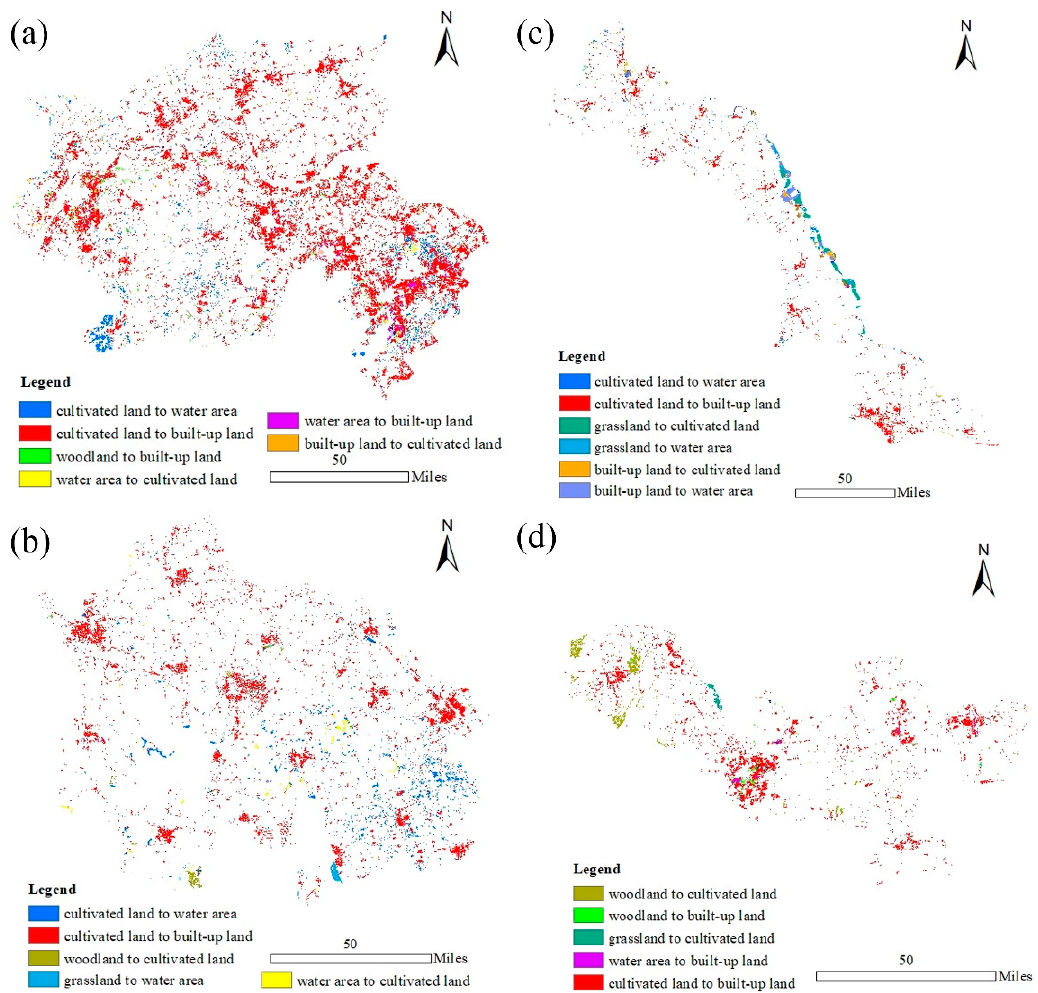
Figure 4. The spatial distributions of land use/land cover transfers from 1995 to 2015 in the four functional regions, where ( a ), ( b ), ( c ) and ( d ) represent the Yangtze River City Group, Coastal Economic Belt, Jianghuai Ecological Economic Region and Huaihai Economic Region, respectively. Table 6. The correlation coefficients between land-use changes and driving